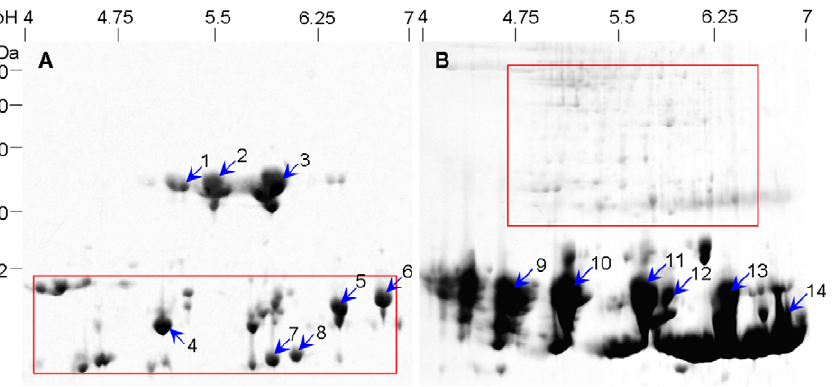
Figure 4. Sequential protein extraction improving 2-DE profiles of P.ternata tuber proteins. A , acid extract; protein load 200 m g. B , SDS extract, protein load 400 m g. Rectangles: used to highlight different protein patterns in two gels, indication more new protein spots emerged. Shown were representative CBB-stained gels.